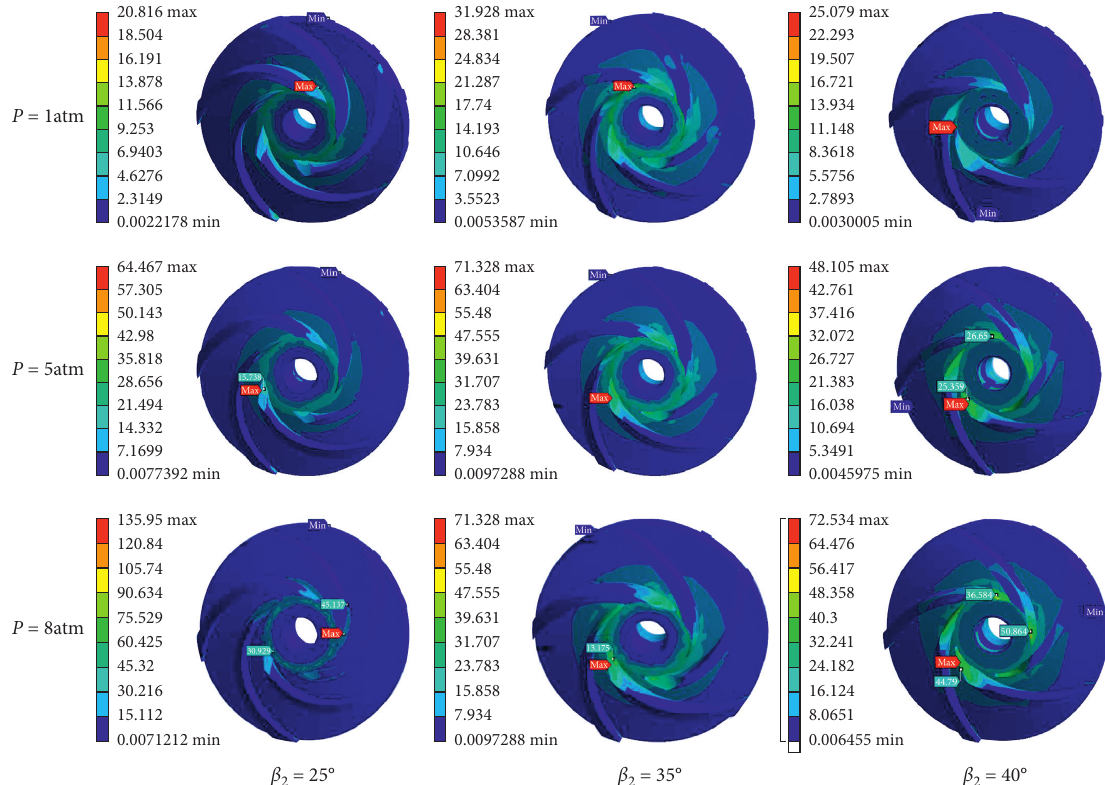
Figure 15: The equivalent stress diagram of each impeller under different fluid loads.